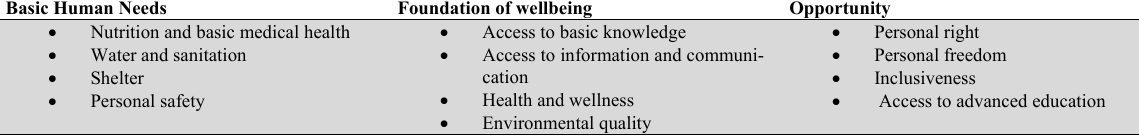
Social Progress Index component-level